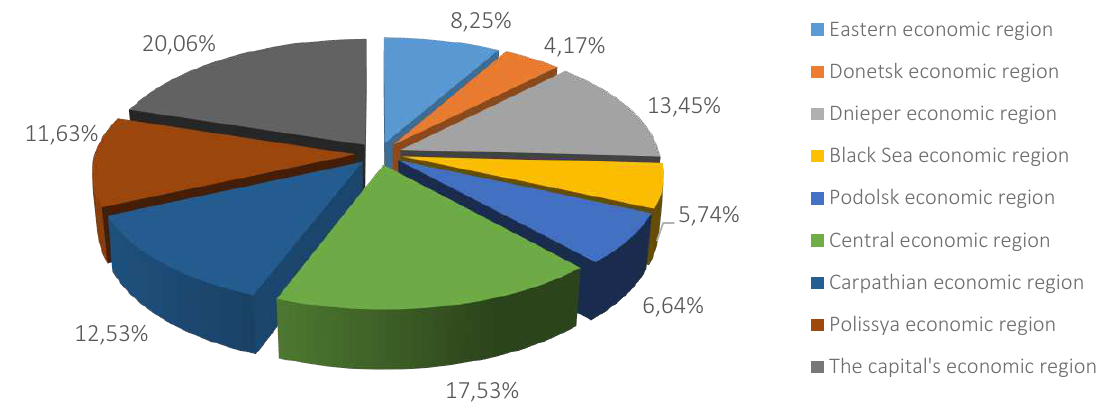
Figure 3. Regional distribution of Ukrainian households whose members identify themselves as middle class